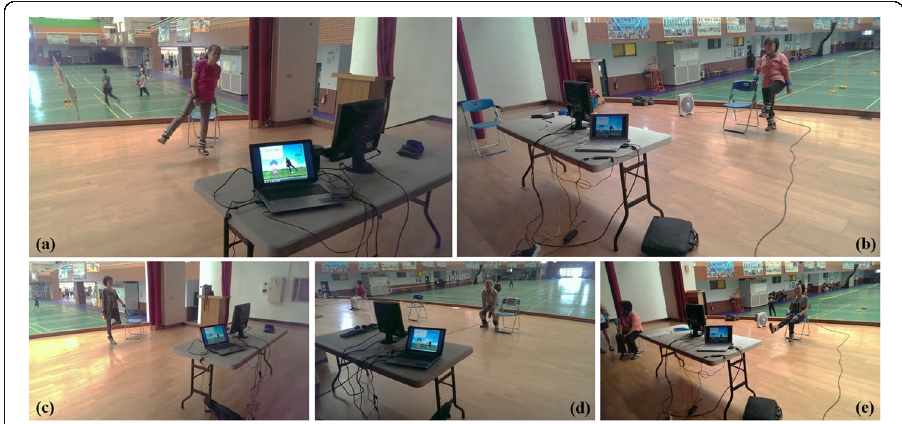
Fig. 12 Executing the functional fitness exercise a Standing side leg raise; b Standing knee marching; c Standing quadriceps stretch; d Wide squats; e Sitting knee